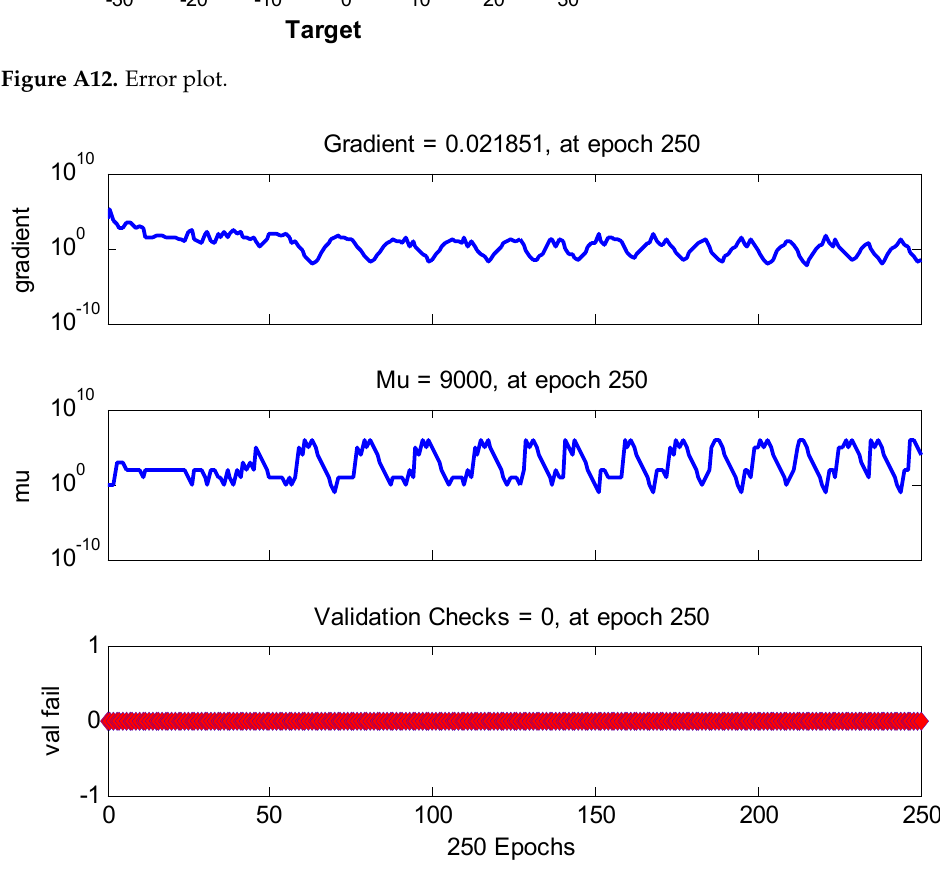
Figure A13. Characteristics of the FNN controller.